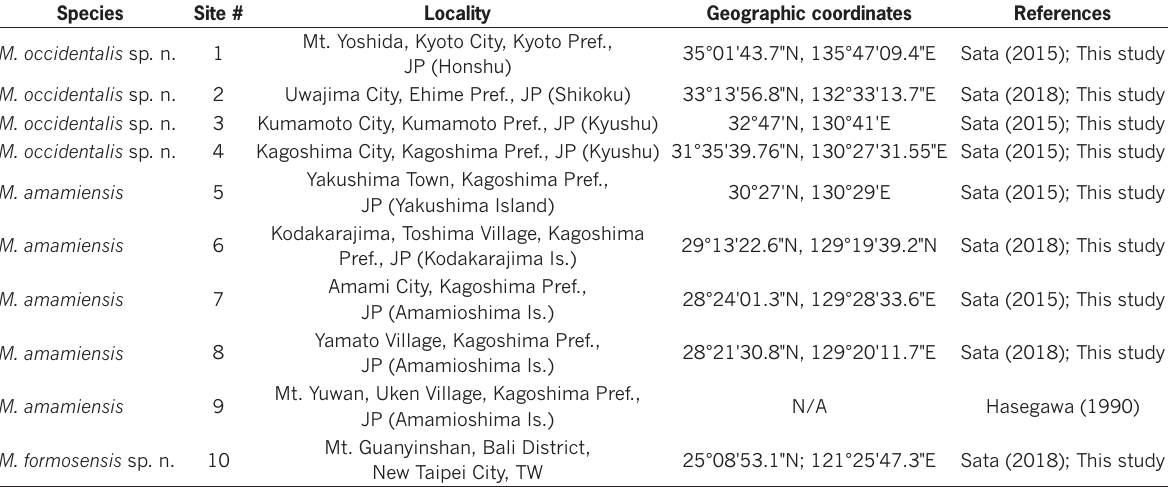
Table 1. Distributions of Meteterakis formosensis sp. n., Meteterakis occidentalis sp. n., and M. amamiensis Hasegawa,